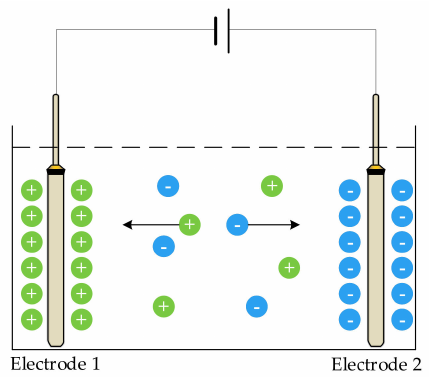
Figure 1. Schematic diagram of the polarization effect.